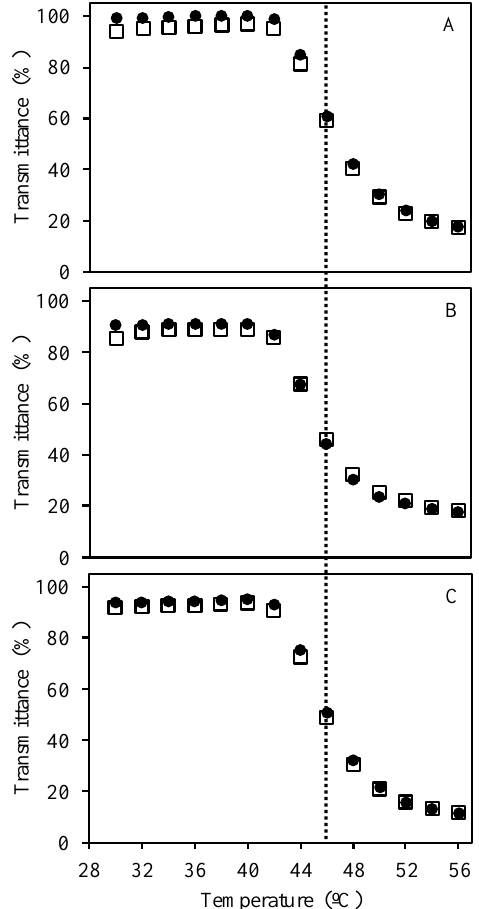
Figure 2. Variation of transmittance (at 400 nm) with temperature for heating (circles) and cooling (squares) cycles for ( A ) block copolymer chains in water, and for mixtures of ( B ) 1:1 SRP:DNA and ( C ) 2:1 SRP:DNA in water. Samples in ( B , C ) have a SRP concentration of 1 × 10 − 5 M. The dashed lines represent the volume phase transition temperature, T VPT = 46 ◦